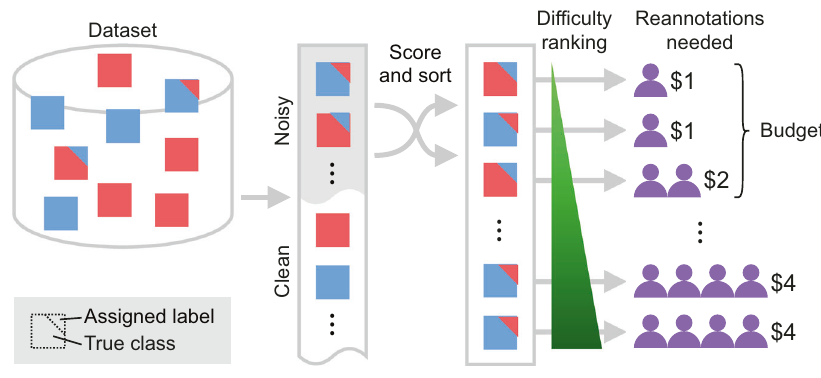
Fig. 1 Overview of the proposed active label cleaning. A dataset with noisy labels is sorted to prioritise clearly mislabelled samples, maximising the number of corrected samples given a fi xed relabelling